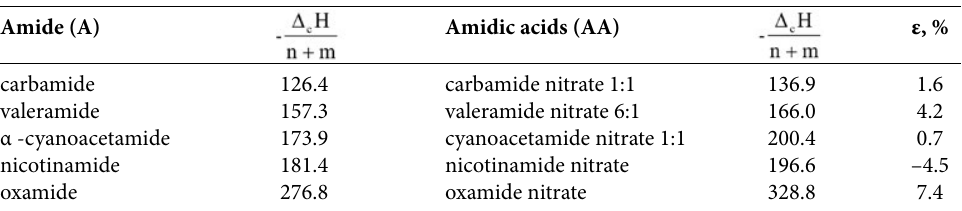
Table 3. The relationship between the normalized values of the enthalpies of combustion of amides and their correspond- ing amidic acids (nitrates) Amide (A) Amidic acids (AA)